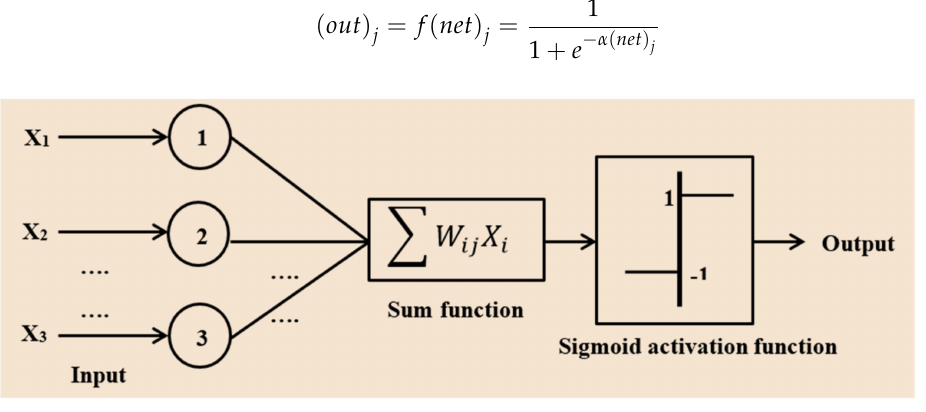
Figure 6. Indication of the neural